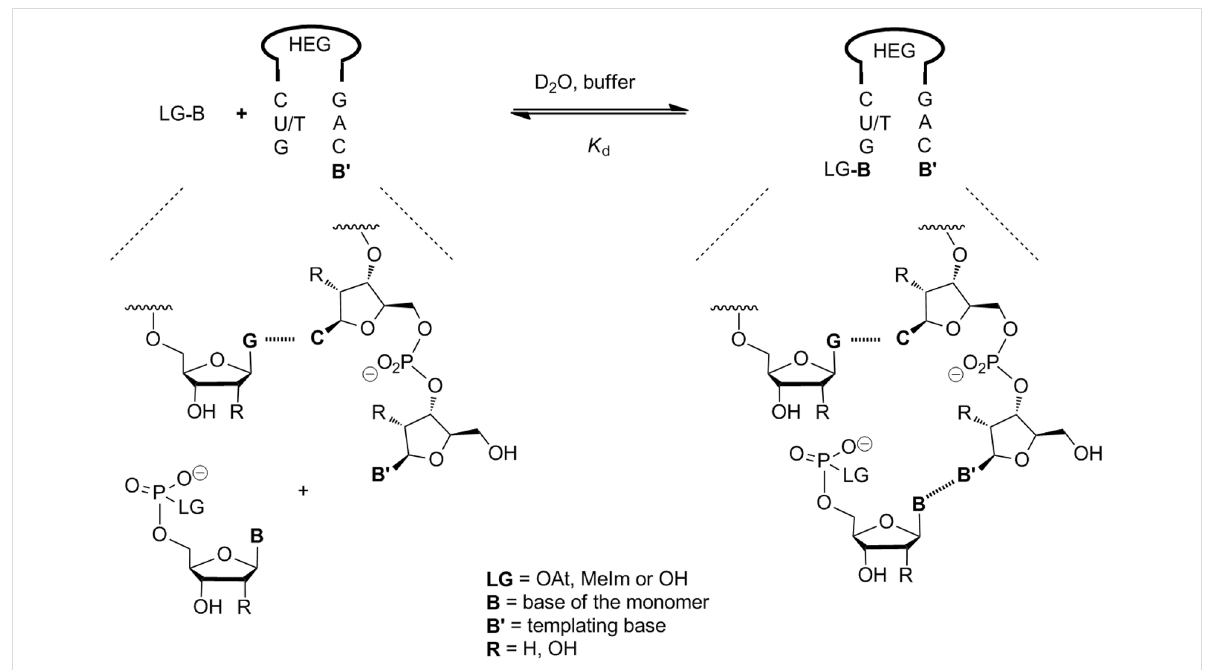
Figure 8: Binding equilibrium between mononucleotides and hairpins representing primer–template duplexes, as chosen for measuring dissociation constants by NMR titration.